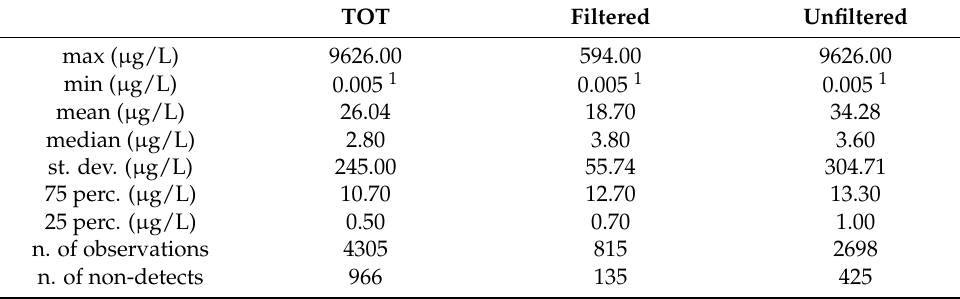
Table 1. Statistics for the total, filtered, and unfiltered As